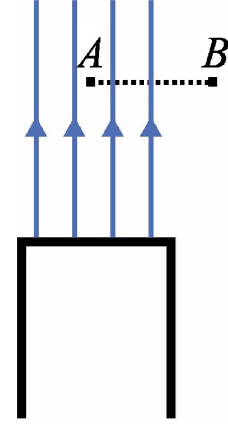
FIG. 2. Fluid jet immersed in a still